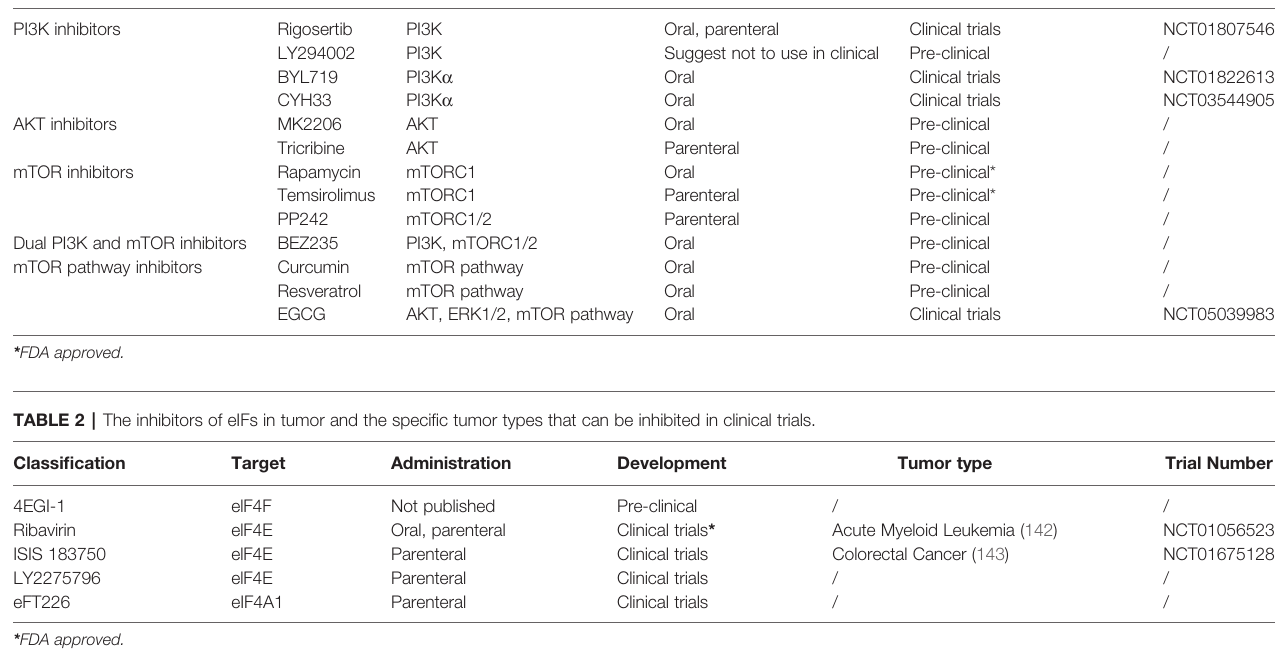
TABLE 1 | The researches about inhibitors of PI3K/AKT/mTOR pathway in ESCC. Classi fi cation